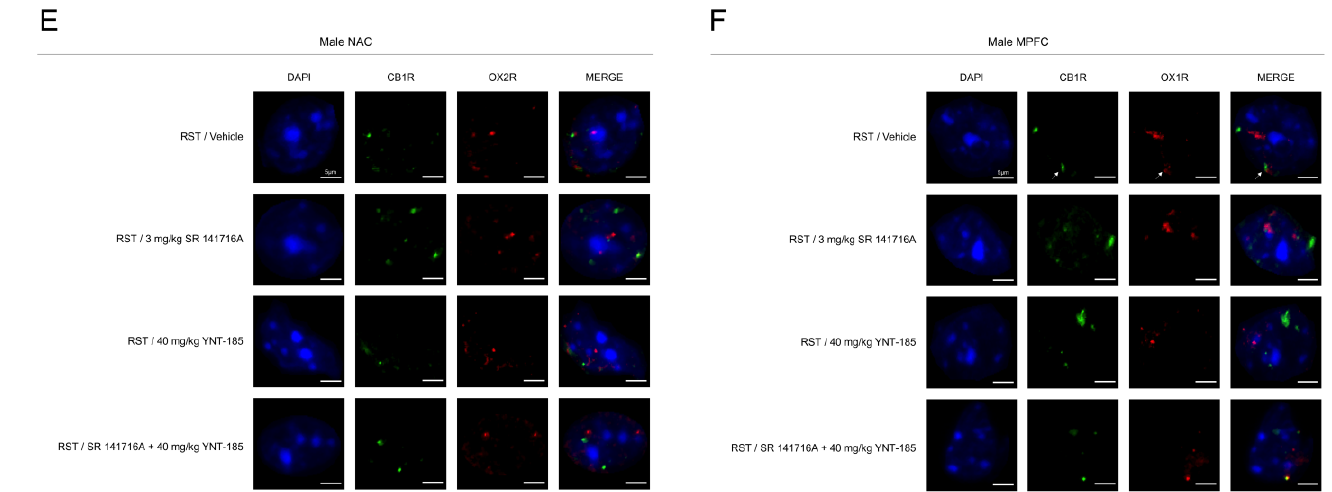
Figure 6. Cannabinoid receptor type 1 and OX2R colocalization in mesocorticolimbic brain regions of male mice that had undergone 24 h RST and drug treatments. ( A – C ), CB1R-OX2R colocalization in the VTA ( A , D ), NAC ( B , E ), and MPFC ( C , F ) of 200 µL vehicle, 3 mg/kg SR141716A, 40 mg/kg YNT-185, and 3 mg/kg SR141716A + 40 mg/kg YNT-185-treated adult male C57BL/6 mice. Succeeding the final sucrose preference measurement on day 8, mice were euthanized for their brains to be perfused for immunohistochemistry. A Zeiss LSM880 confocal microscope obtained the receptor colocalization images. Analysis of these images was done via FIJI and ImageJ (version 2.1.0). Colocalization data are expressed as Pearson’s correlation coefficients for n = 10 cells per treatment group randomly selected from three male mice. Means ± SEM were used to determine statistical significance using a two-way ANOVA and Tukey’s post-hoc analysis. * p < 0.05 compared between drug treatments within No 24 h RST. @ p < 0.05 compared between drug treatments within 24 h RST. # p < 0.05 compared between No 24 h RST and 24 h RST within drug treatments. ( D – F ), Representative images of CB1R-OX2R colocalization in the VTA ( D ), NAC ( E ), and MPFC ( F ) of males subjected to RST, which associate with graphs ( A – C ), respectively. In the figure above “+” refers to with RST and “-“ refers to without RST.